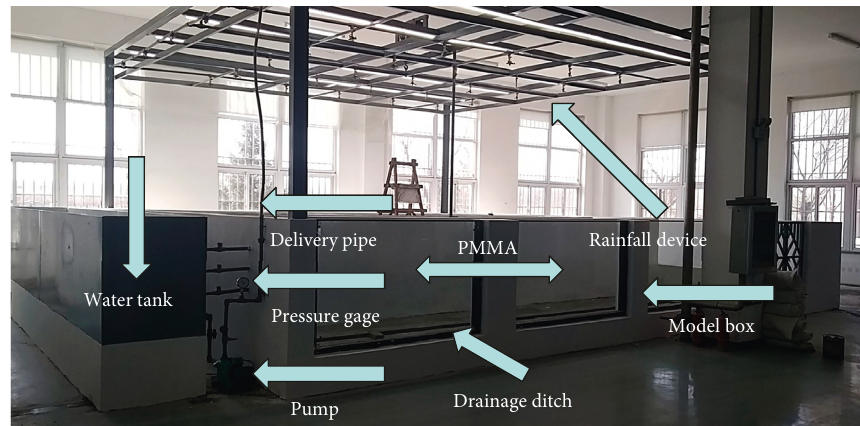
Figure 3: Rainfall test model for tailings slope.